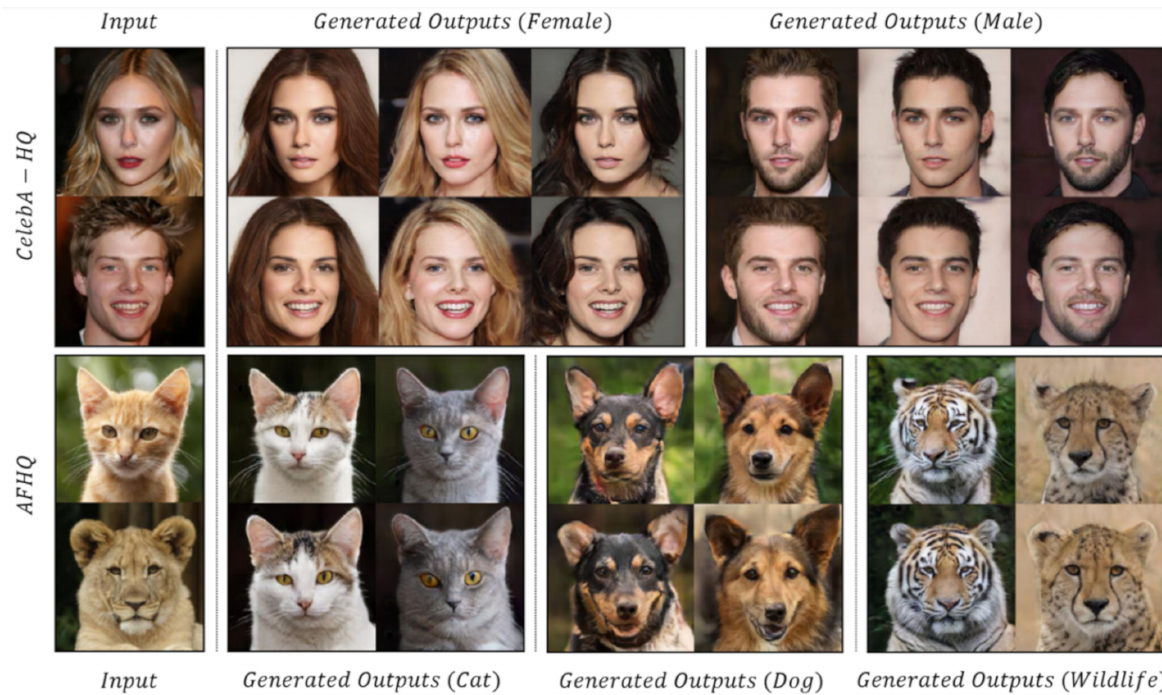
Figure 13. Image generated by StarGANv2 trained with CelebA (large-scale Celeb faces’ Attributes High Quality), AFHQ (Animal Faces High Quality) datasets [44].